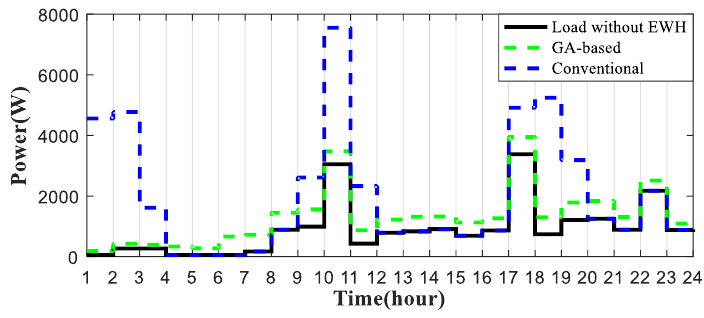
Figure 13. Comparison of load difference between GA-based and conventional.